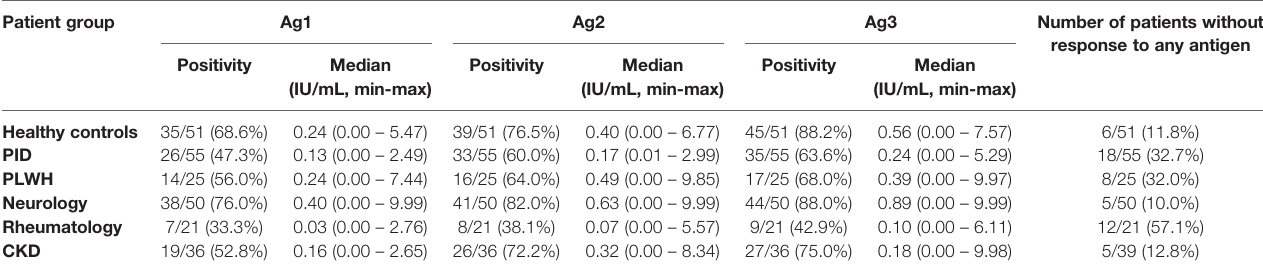
TABLE 3 | Cellular immune response against each antigen (cut-off: 0.15 IU/mL) for each patient group at T3. Results are presented as number of positive patients per total number of patients at T3. Patient group